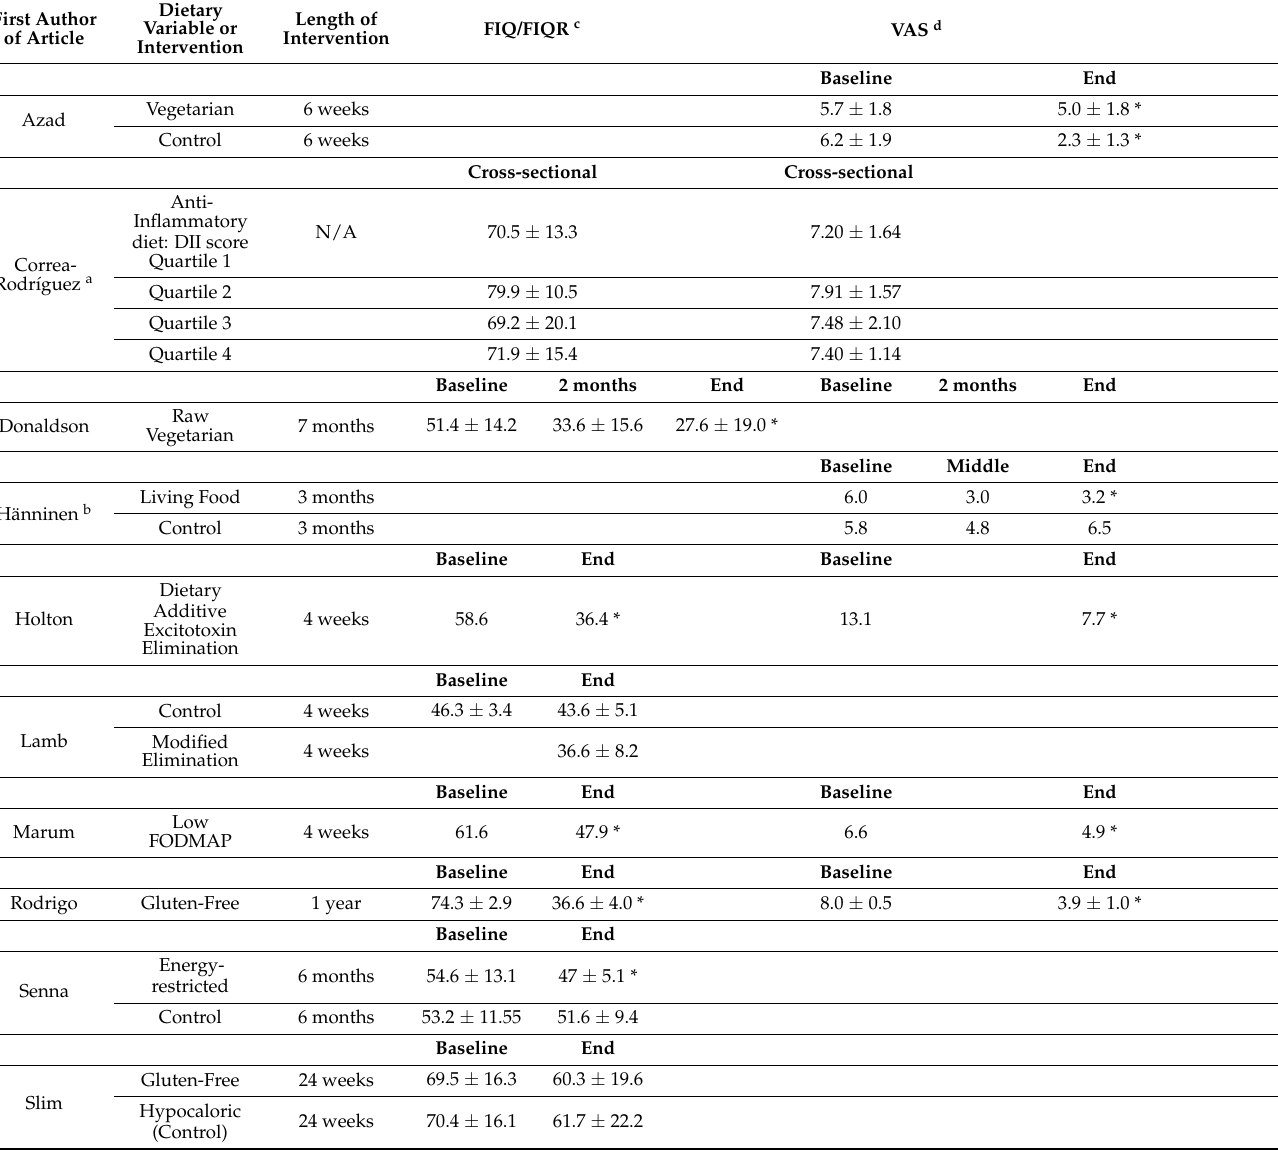
Table 2. Effects of diets on pain symptoms measured by Revised Fibromyalgia Impact Questionnaire (FIQR) and Visual Analogue Scale for Pain